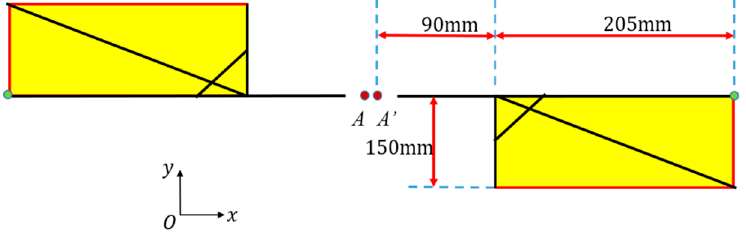
Figure 3. Dimensions of the rectangle wings for the flapping wing rotor.